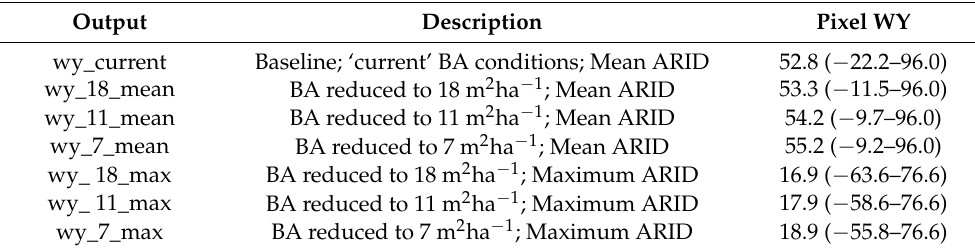
Table 2. Summary of output spatial datasets produced for timber thinning and climate scenarios, with variation in inputs for ARID. The mean (and range) summary statistics are from individual pixel values in units of cm per